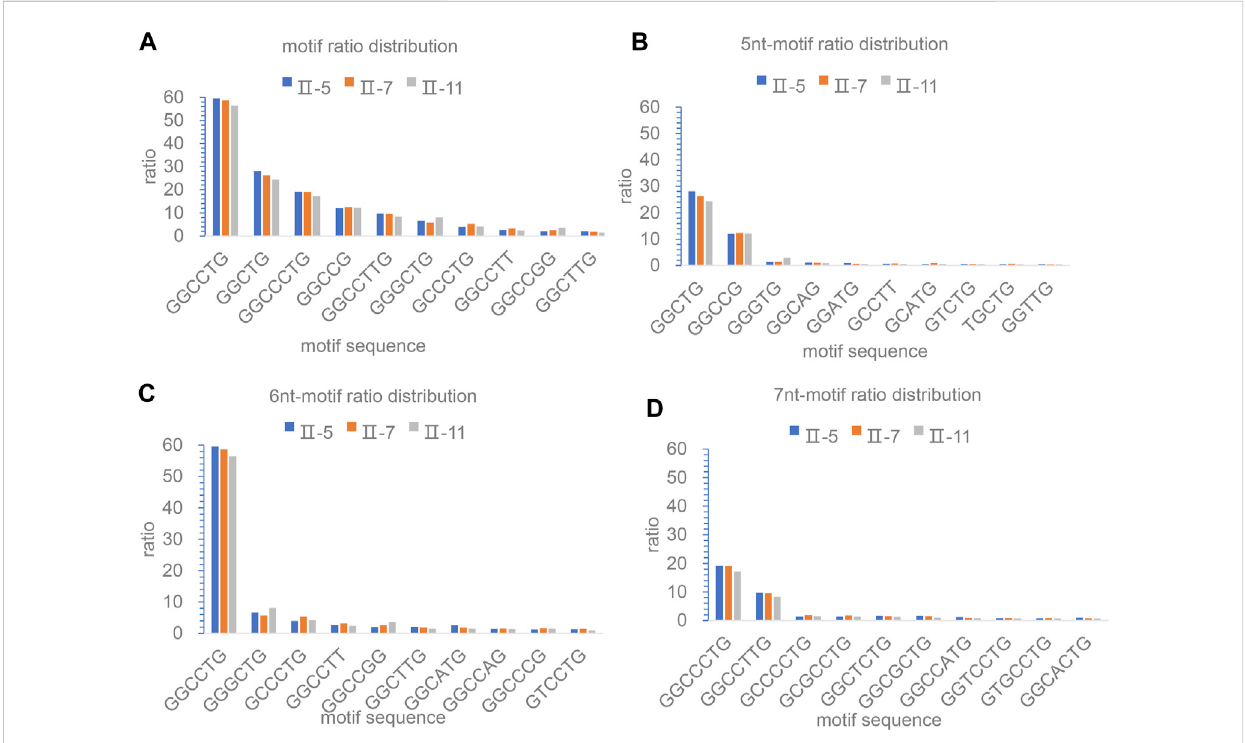
FIGURE 4 The analysis and illustration of the motifs based on the SMRT sequencing. The motif of all subreads ratio distribution in the region of repeat expansions. The ratio is calculated as in percent of the nucleotides of each motif divided by the total number of nucleotides for each expansion. The Top 10 motif (A) , Top 10 5 nt-motif (B) , 6 nt-motif (C) and 7 nt-motif (D) of all subreads ratio distributions in the region of repeat